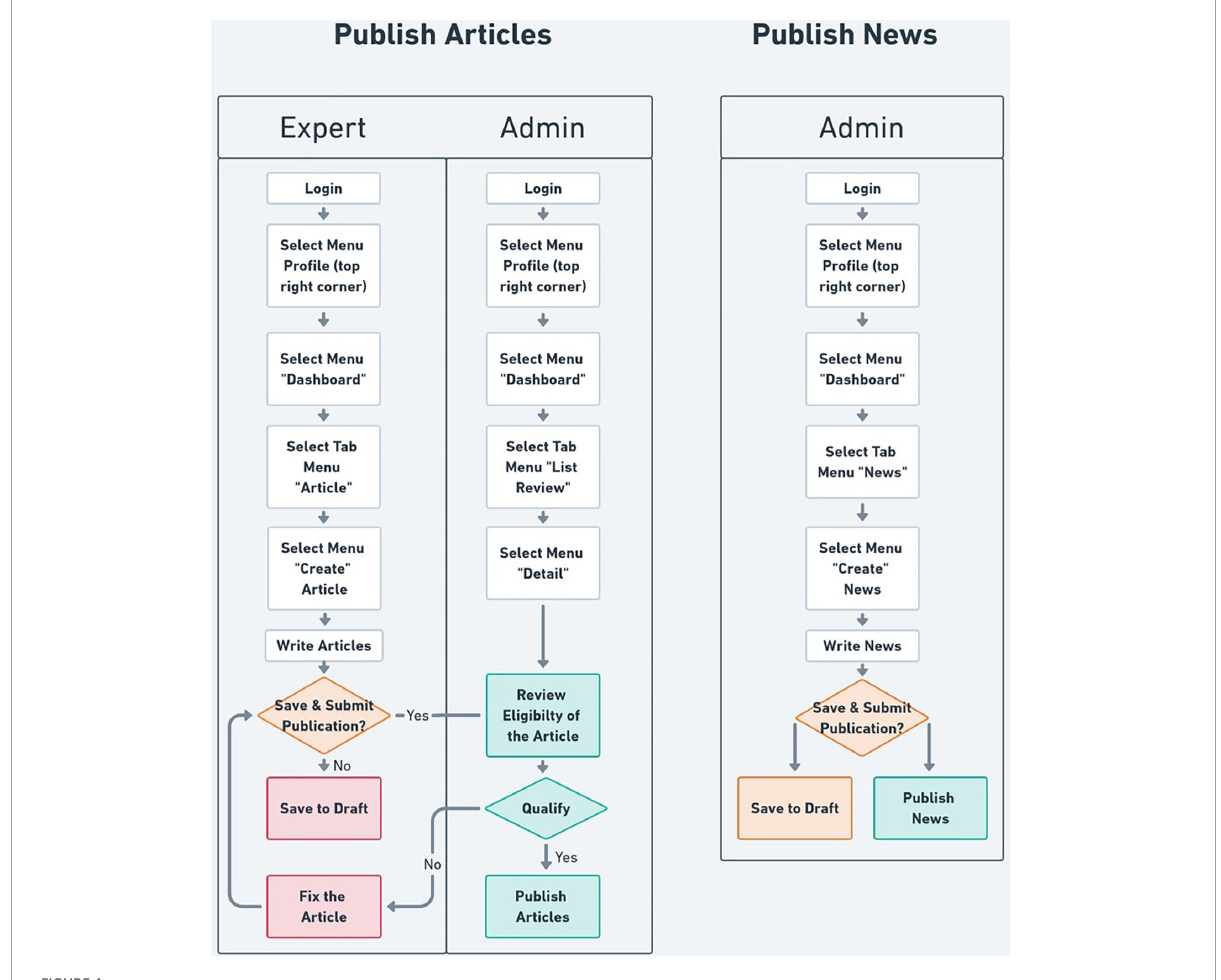
FIGURE4 Flow chart publish articles and